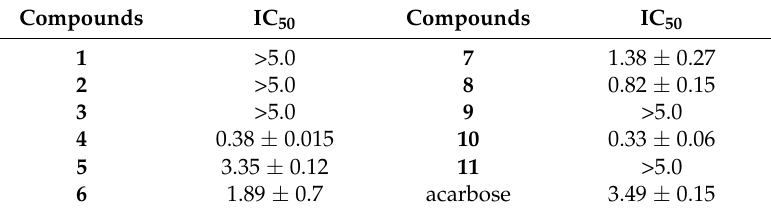
Table 3. The IC 50 (mM) values of α -glucosidase inhibitory activity of the isolated compounds, 1 – 11 , and acarbose as the control. Each value is shown as a mean ± standard derivation of three replicates. Compounds IC